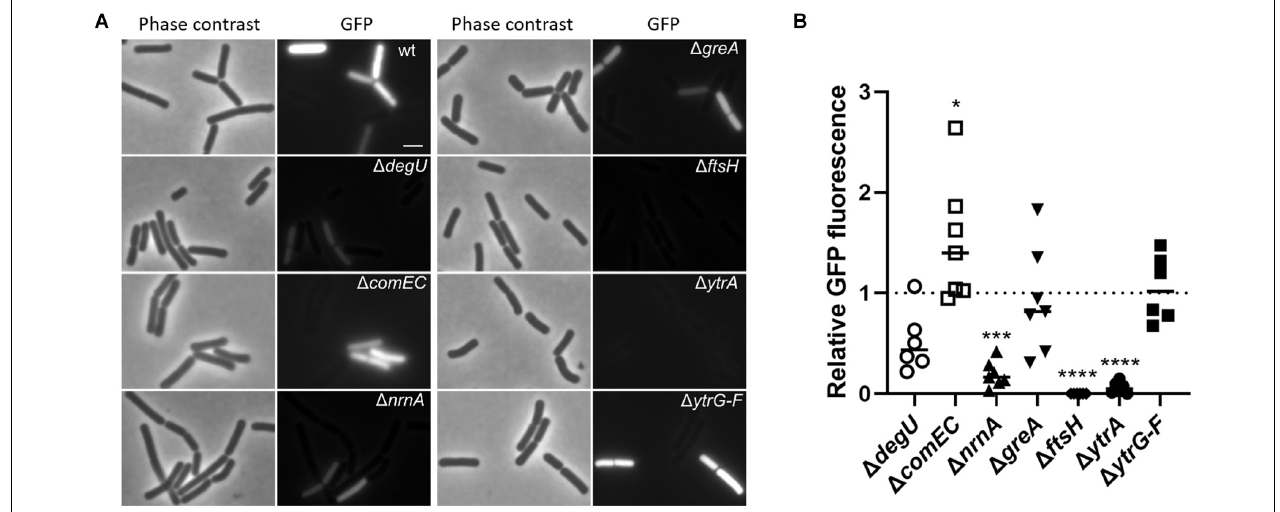
FIGURE 1 | Effect of gene deletions on the expression of a P comG -gfp translational fusion as a readout for the activity of the competence transcription factor ComK. (A) Strains harboring the P comG -gfp construct were grown in competence inducing medium as described in section “Materials and Methods.” Cells were analyzed by phase contrast and fluorescence microscopy and representative images are shown. Scale bar is 2 µ m. (B) The percentage of GFP-expressing cells was determined for each strain. The ratio of GFP-expressing cells of each mutant compared to the wildtype strain was calculated and the result of at least six independent experiments plotted. For statistical analysis, a one-way ANOVA followed by a Dunnett’s multiple comparison test was used (* p ≤ 0.05, *** p ≤ 0.001, and **** p ≤